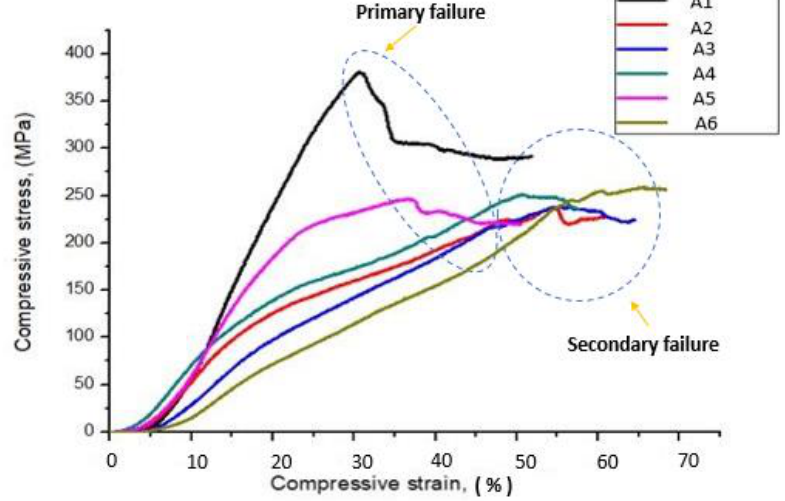
Figure 6. GF/SF/CTS hybrid sandwich composite scaffolds in a three-point bending.